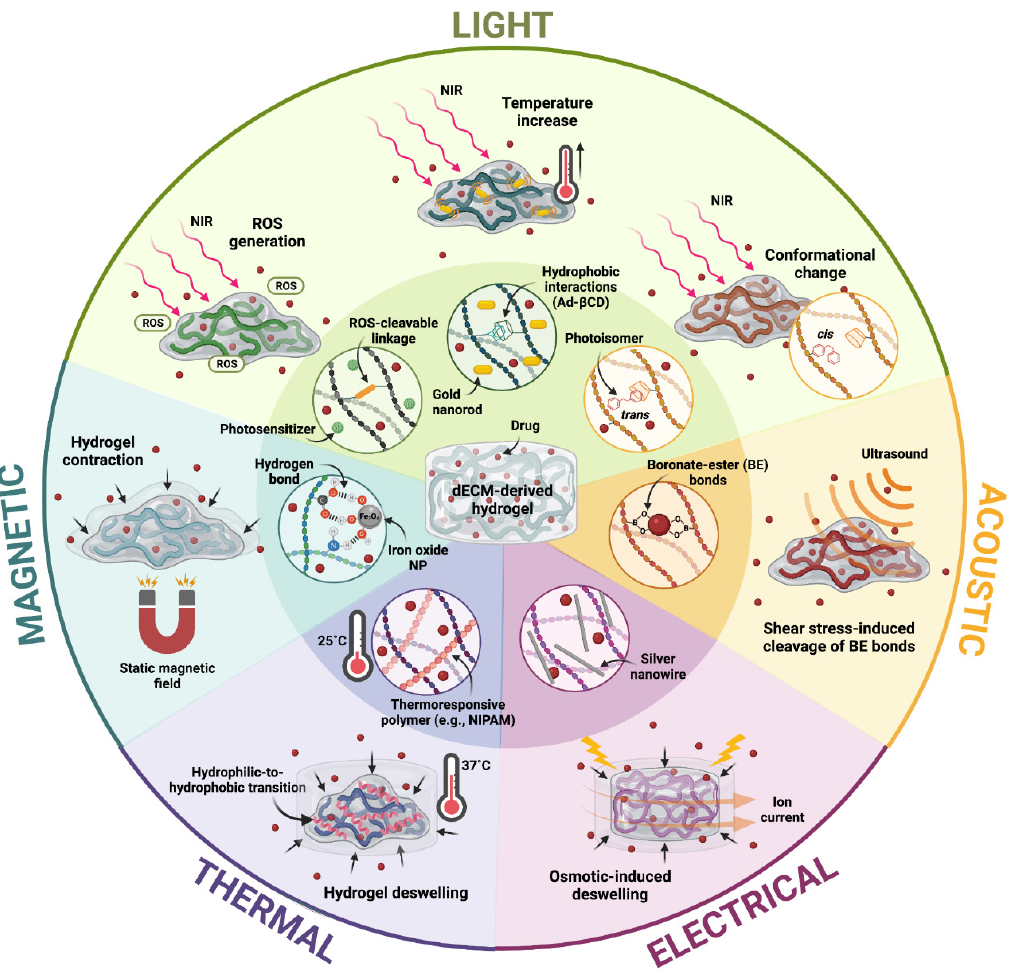
Figure 5. General schematic of drug release mechanisms from dECM-derived hydrogels induced by external stimuli, namely light, temperature, or magnetic, acoustic, and electric fields. Hydrogel destabilization, degradation, or deswelling as a consequence of these stimuli mediates the release profiles of encapsulated molecules or drugs (Created with BioRen- der.com).